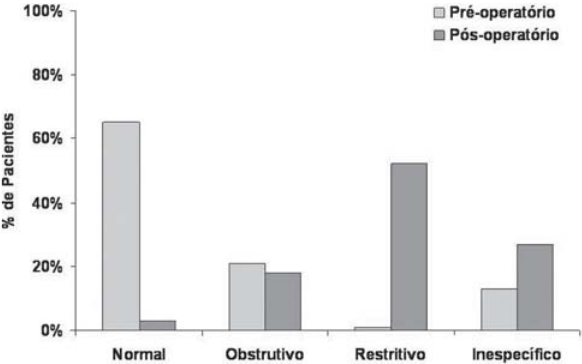
Fig. 1 - Comparação do distúrbio ventilatório do pré-operatório para o sexto dia de